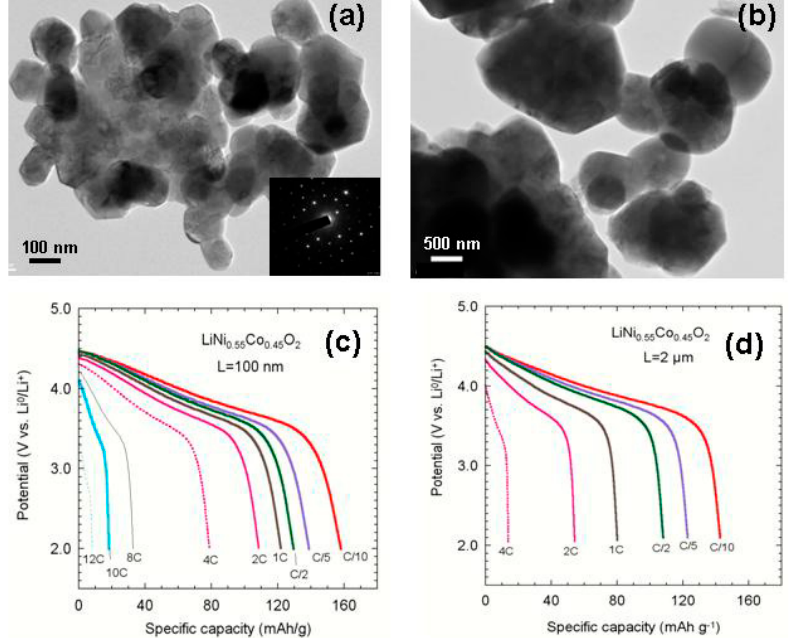
Figure 4. HRTEM images of LiNi 0.55 Co 0.45 O 2 layered powders with different particle sizes: ca. 100–150 nm ( a ) and 1.5–2.0 µm ( b ) and discharge profiles as a function of C-rate for Li//LiNi 0.55 Co 0.45 O 2 coin-type cells with two cathode materials of 100 nm and 2 µm particle size. The good crystallinity of powders is shown by the electron diffraction diagram (inset); ( c ) discharge curves for 100–150 nm; ( d ) discharge curves for 1.5–2.0 µm.